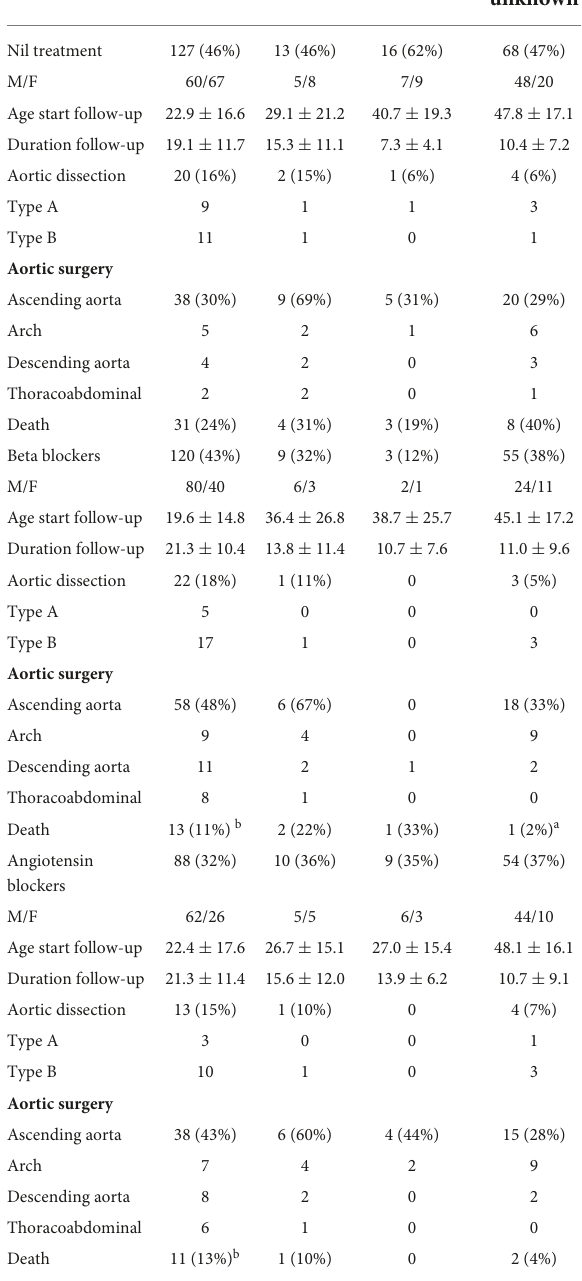
TABLE 3 Medications and clinical outcomes during follow-up. Marfan Loeys-